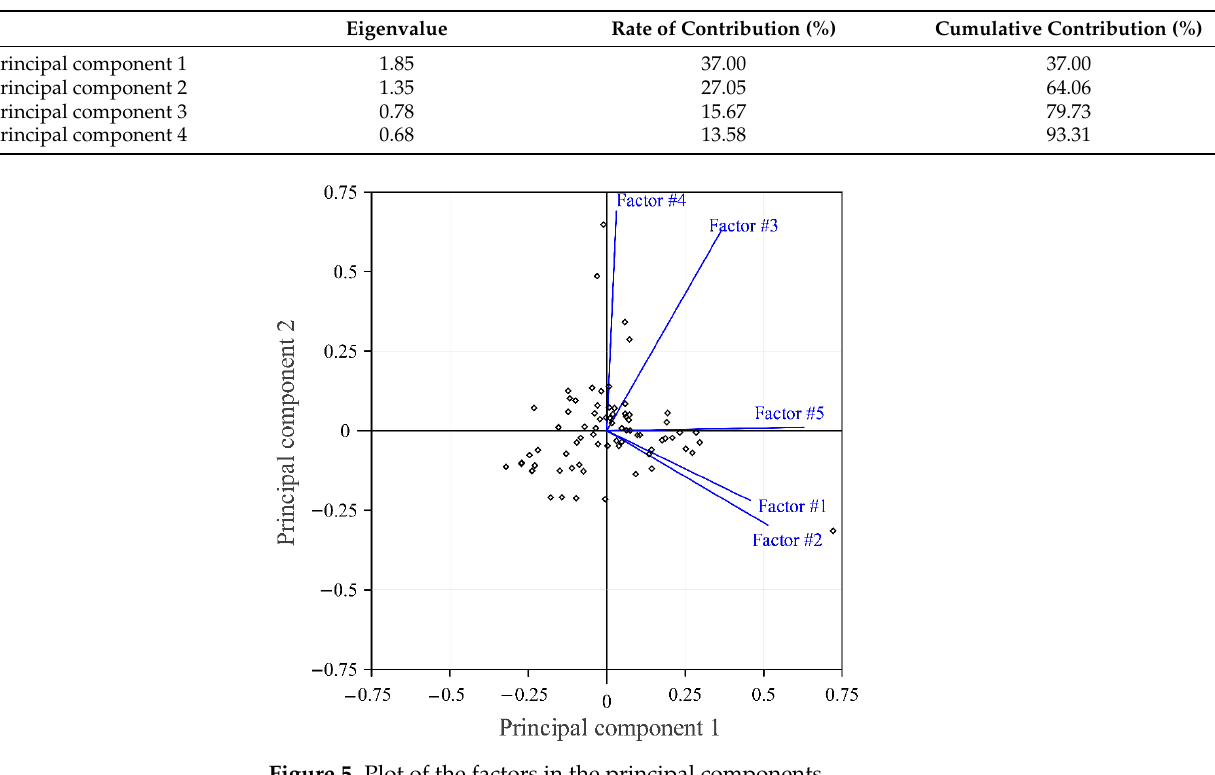
Figure 5. Plot of the factors in the principal